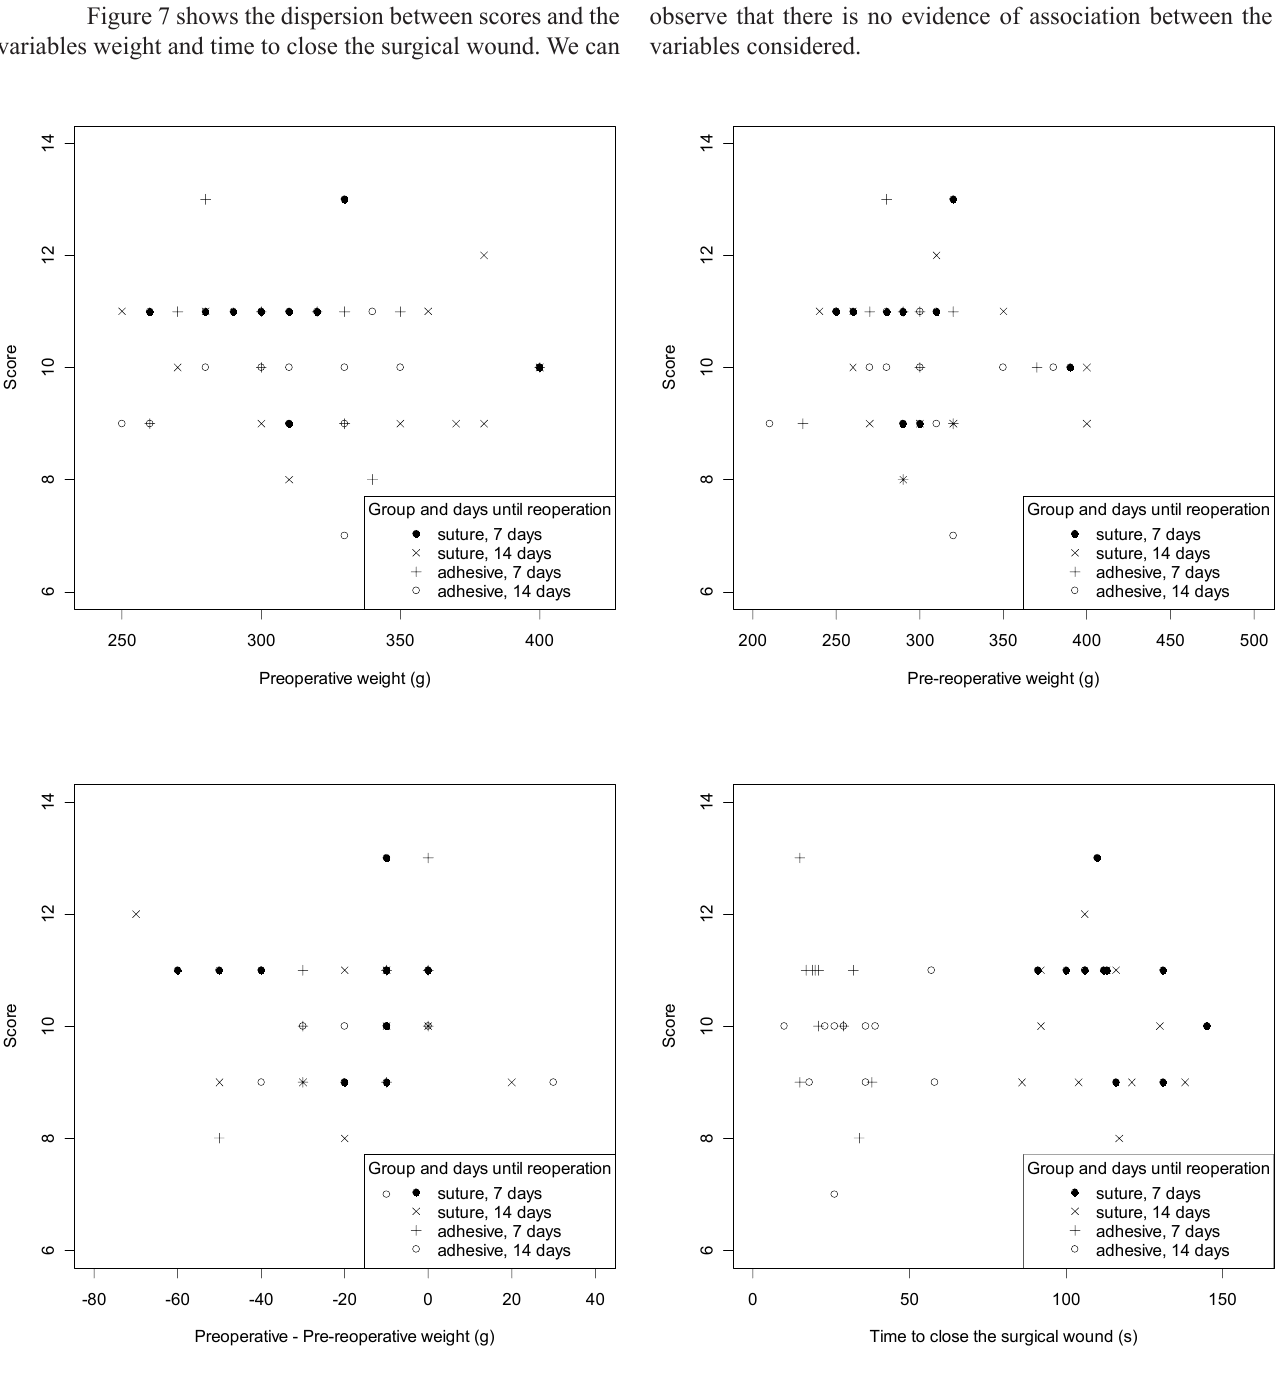
FIGURE 7 – Graphs showing the dispersion between scores and the following variables: preoperative weight, pre-reoperative weight, weight difference, and time to close the surgical